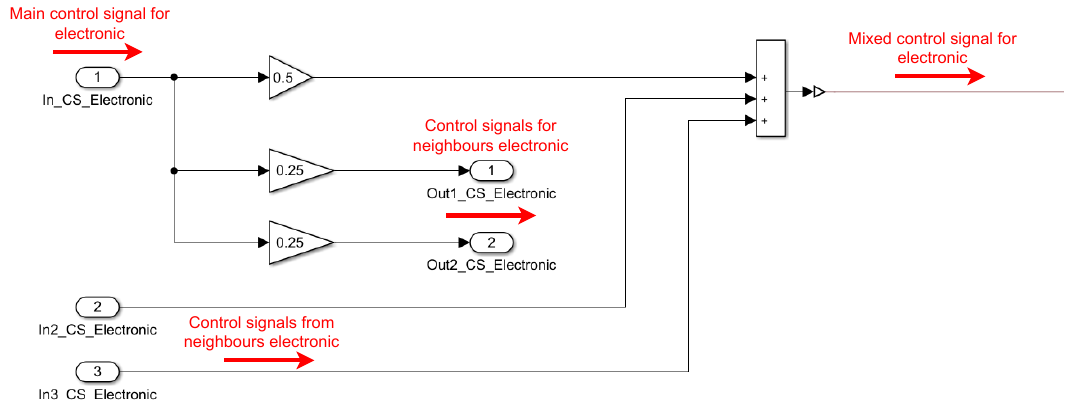
Figure 16. The section internal structure: the control part.